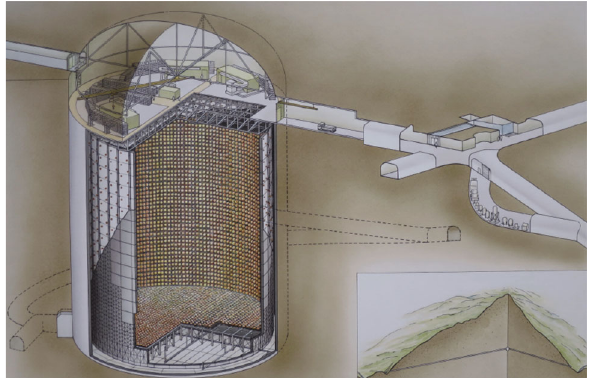
Fig. 1 Super-Kamiokande Detector. The 50 kton water is viewed by ∼ 11 , 000 photomultiplier tubes (PMT) and placed 1000 m underground